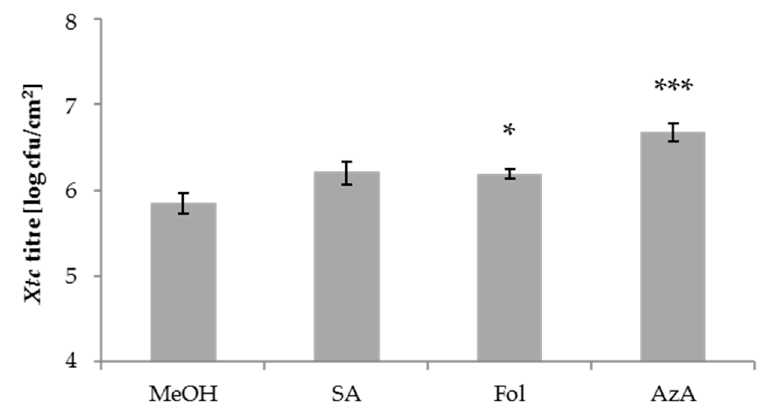
Figure 2. Xtc titres in salicylic acid (SA)-, Fol- and AzA-treated barley plants. Barley cultivar GP plants were sprayed with 0.05% MeOH as control, 1 mM SA, 500 µ M Fol, or 1 mM AzA in 0.01% Tween-20 as indicated below the panel. One day later, the second true leaves of the plants were inoculated with Xtc by syringe infiltration. The resulting Xtc titres in leaf 2 at 4 dpi are shown. Bars represent the average of 8–9 replicates from 3 biologically independent greenhouse experiments ± standard error, replicates were as follows: MeOH: 9 (3 + 3 + 3), SA: 9 (3 + 3 + 3), Fol: 8 (3 + 3 + 2), AzA: 8 (3 + 3 + 2); asterisks above bars indicate statistically significant differences from the mock control treatment (one-way ANOVA and post hoc Dunnett’s test, * p < 0.05, *** p < 0.0005).